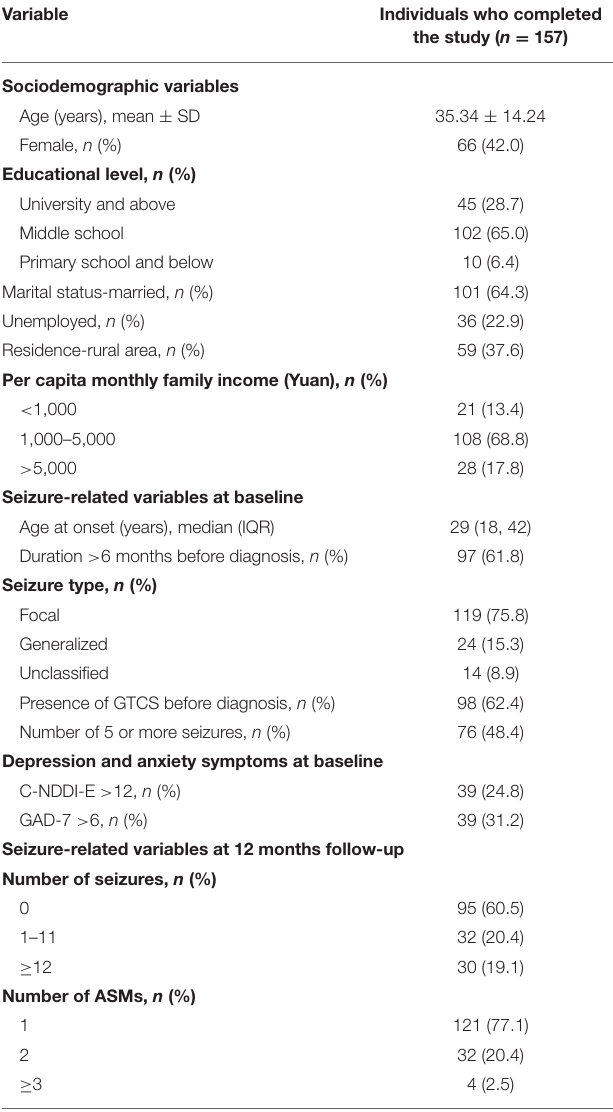
TABLE 1 | Patient characteristics. TABLE 2 | Comparison of anxiety symptoms between baseline and 12 months